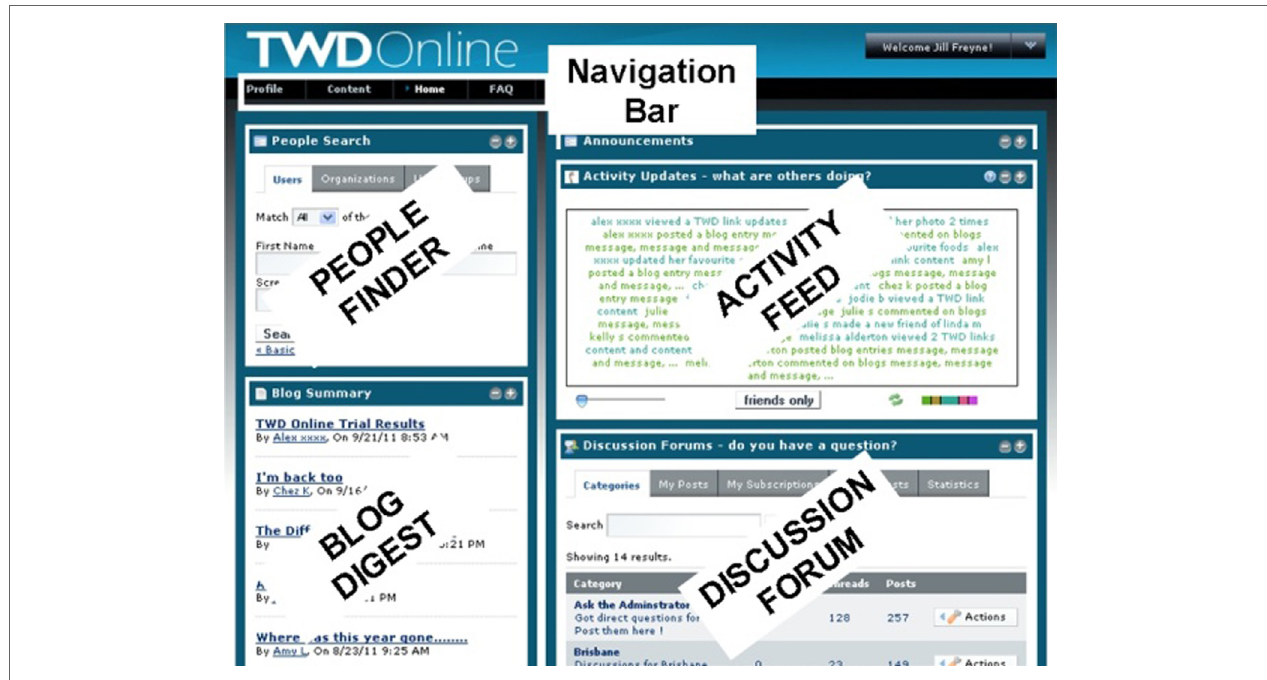
FigUre 1 | TWD online portal